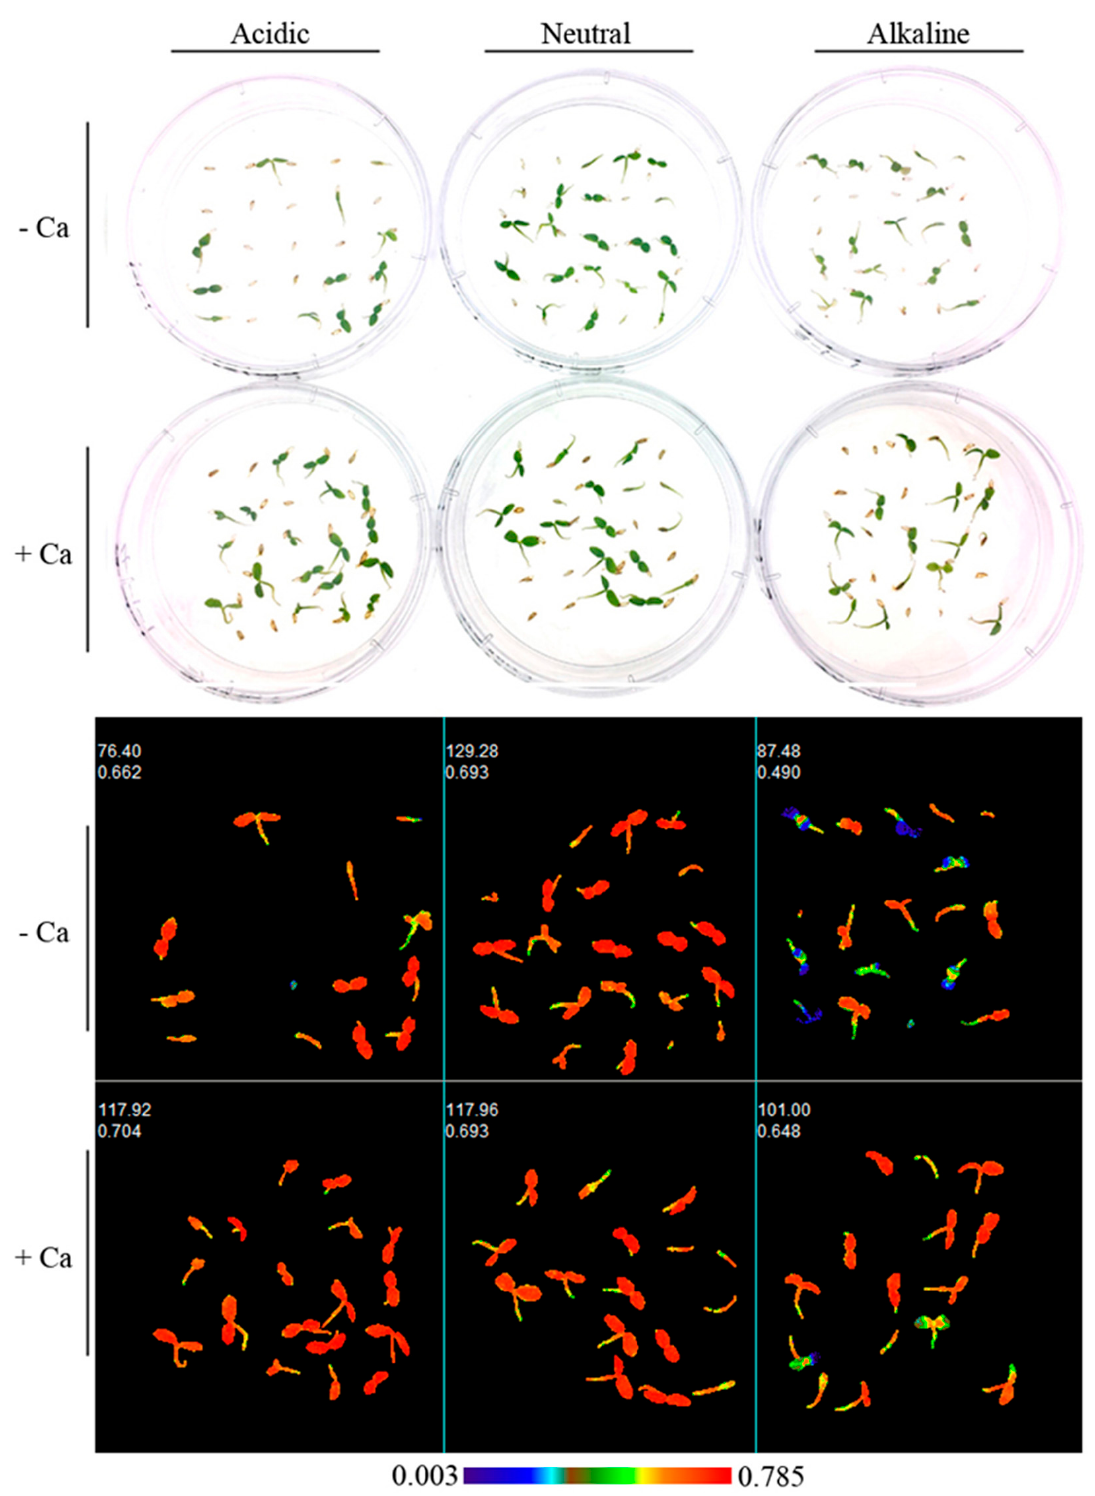
Figure 6. RGB images and F v /F m images on day 41 of R. fortunei in 6 treatments (acidic, neutral, alkaline, acidic + Ca 2+ , neutral + Ca 2+ , alkaline + Ca 2+ ). Values in the upper left corner of the chlorophyll fluorescence images are the projected area in pixels and mean values of F v /F m of all seedlings in one petri dish.